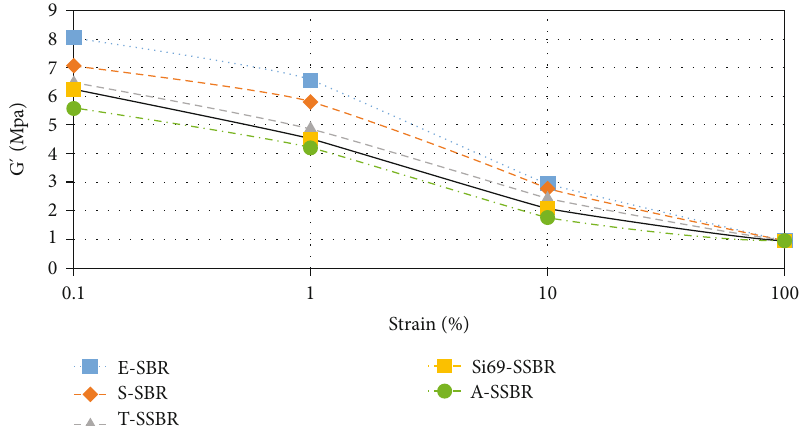
Figure 10: The variation in G ′ with strain.